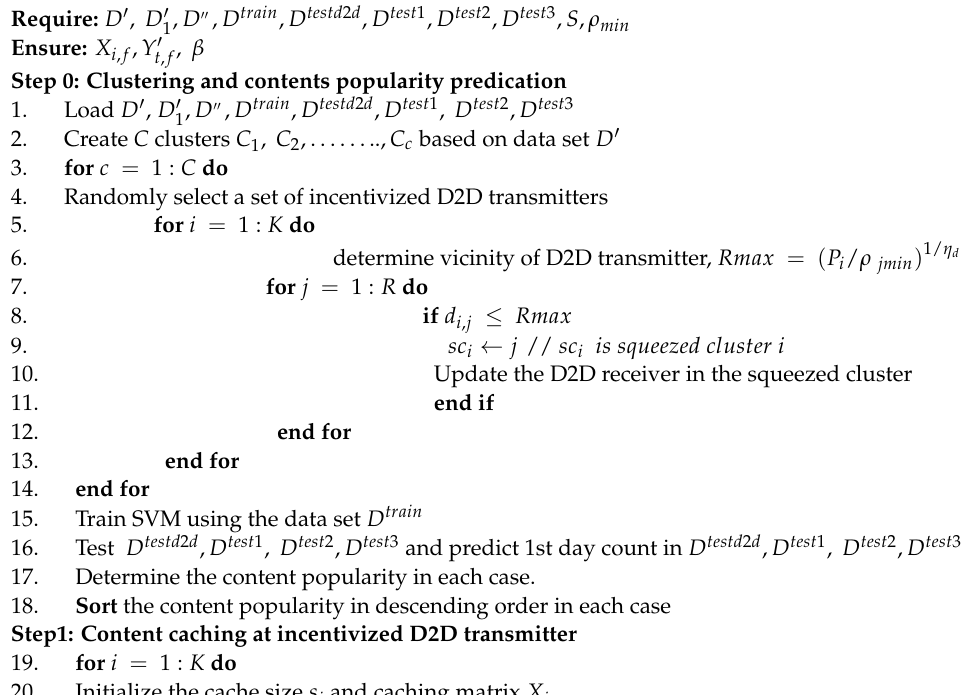
Algorithm 1. Clustered-SVM to Predict Content Popularity and Implement Decision Making